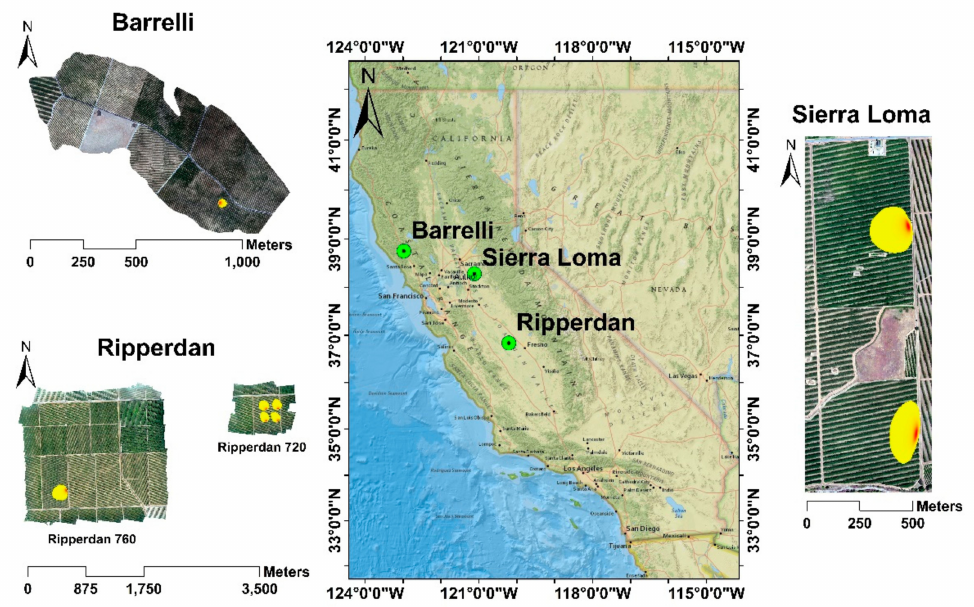
Figure 2. Layout of study vineyards in Central Valley, California with estimated typical flux foot- print/source area for the EC towers.